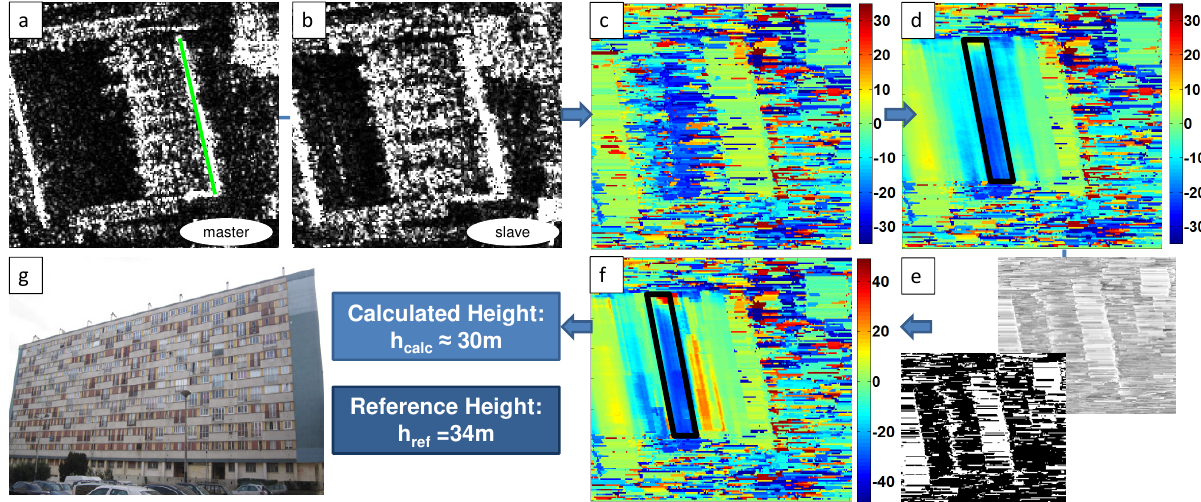
Figure 6: Result of height determination; a) corner line extraction on master image (asc. 47°); b) slave image (asc. 36°); c) disparity map calculation with l temp =39 and l search =109; d) result of filtering with mean method and observable parallelogram P 2 ; e) correlation map and binary image corresponding to correlation values higher than 0.85; f) height map after weighted filtering; g) corresponding building